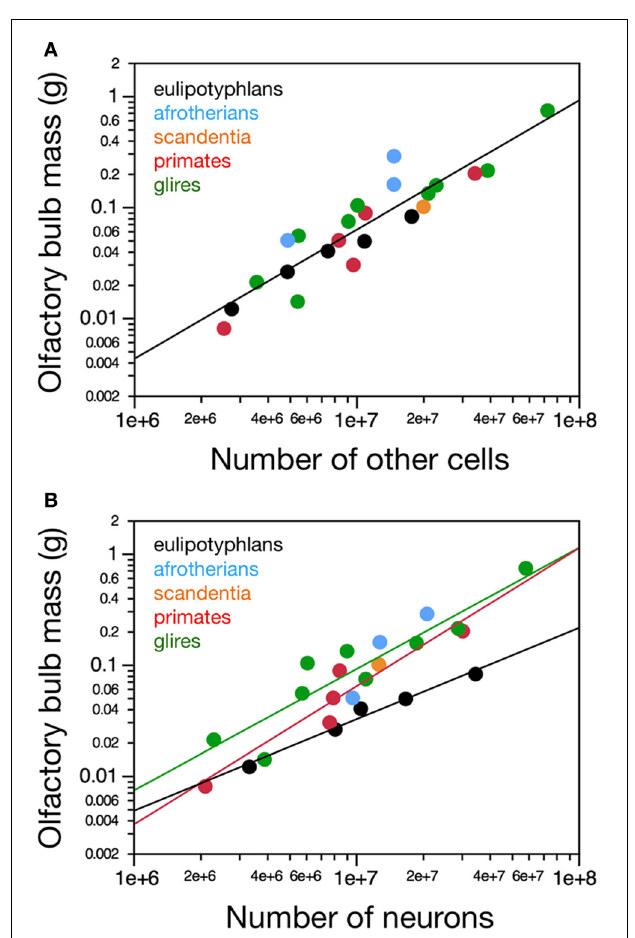
FIGURE 2 | Neuronal and non-neuronal scaling rules for the olfactory bulb. Graphs show the relationship between average mass of both olfactory bulbs in each species and (A) the total number of other FIGURE 1 | Distribution of absolute and relative olfactory bulb mass (non-neuronal) cells or (B) the total number of neurons in them. (A) across species. (A) Average mass of both olfactory bulbs in each species Olfactory bulb mass varies similarly, and linearly, with its number of other and (B) relative mass of the olfactory bulbs expressed as a percentage of cells across the ensemble of eulipotyphlans (black), glires (green), primates, brain mass, both shown as a function of absolute brain mass (which does and scandentia (red and orange), but (B) as a power function of its number not include the olfactory bulbs). Olfactory bulb mass varies linearly with of neurons with an exponent of 0.823 ± 0.071 in eulipotyphlans, 1.092 ± brain mass in eulipotyphlans ( A , black; power function exponent, 0.965 ± 0.170 in glires, and 1.243 ± 0.192 in primates and scandentia. Notice that 0.149, p = 0 . 0075), such that its relative size does not vary systematically eulipotyphlans have more neurons packed into olfactory bulbs of a similar with brain mass ( B , black). In glires, olfactory bulb mass increases more mass in glires or afrotherians. Eulipotyphlan data from Sarko et al. (2009). slowly than brain mass ( A , green; power function exponent, 0.820 ± 0.074, Afrotherian data from Neves et al. (2014). Glires, data from p < 0 . 0001), such that the relative mass of the olfactory bulb decreases Herculano-Houzel et al. (2011) and this study. Primates and scandentia, data with increasing brain mass ( B , green). Afrotherians (blue) overlap with both from this study. eulipotyphlans and glires. In primates and scandentia there is no significant correlation between olfactory bulb mass and brain mass ( A and B , red and orange). (C) The mass of the olfactory bulb increases linearly with the In contrast, different sets of neuronal scaling rules apply to the mass of the cerebral cortex across eulipotyphlans (black; exponent, 0.930 ± olfactory bulb of primates, glires and eulipotyphlans. (Continued)